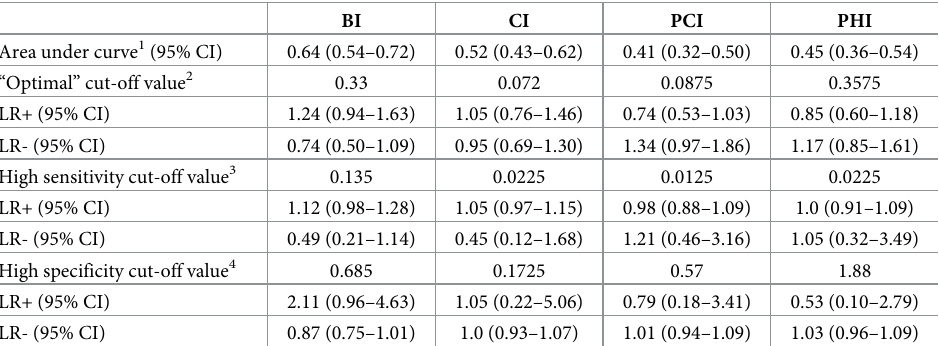
Table 5. Predictive utility of vector indices at cluster